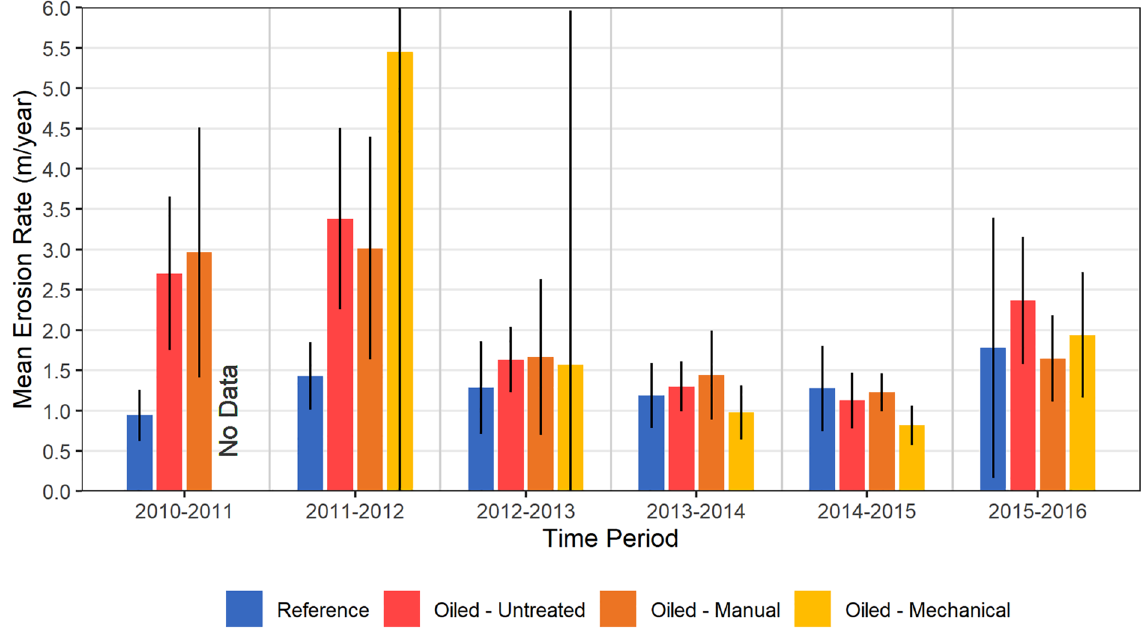
Figure 2. Field measured marsh shoreline erosion rates 2010–2016 (m yr −1 ). Data are means with 90% confidence intervals, n = 5 for Reference, 9 for Oiled-Untreated, 5 for Oiled-Manual, and 2–6 for Oiled- Mechanical treatments (n = 14–20 for Oiled sites combined) depending on year. Due to missing values, the desire to use as much data as possible, and the lack of clear differences among cleanup treatments, we pooled the oiled site data for statistical analysis. Marsh erosion rates differed among Reference and Oiled sites (F 1,17 = 9.751, p = 0.006); among years (F 2.32,39.40 = 2.703, p = 0.072); and for the interaction of oiling and year (F 2.32,39.40 = 2.648, p = 0.076). Pairwise differences (Tukey’s test) among Reference and Oiled sites were observed for 2010–2011 ( p = 0.003) and 2011–2012 ( p = 0.001), but not for other years. See Supplementary Table S1 for detailed two-way mixed ANOVA results.